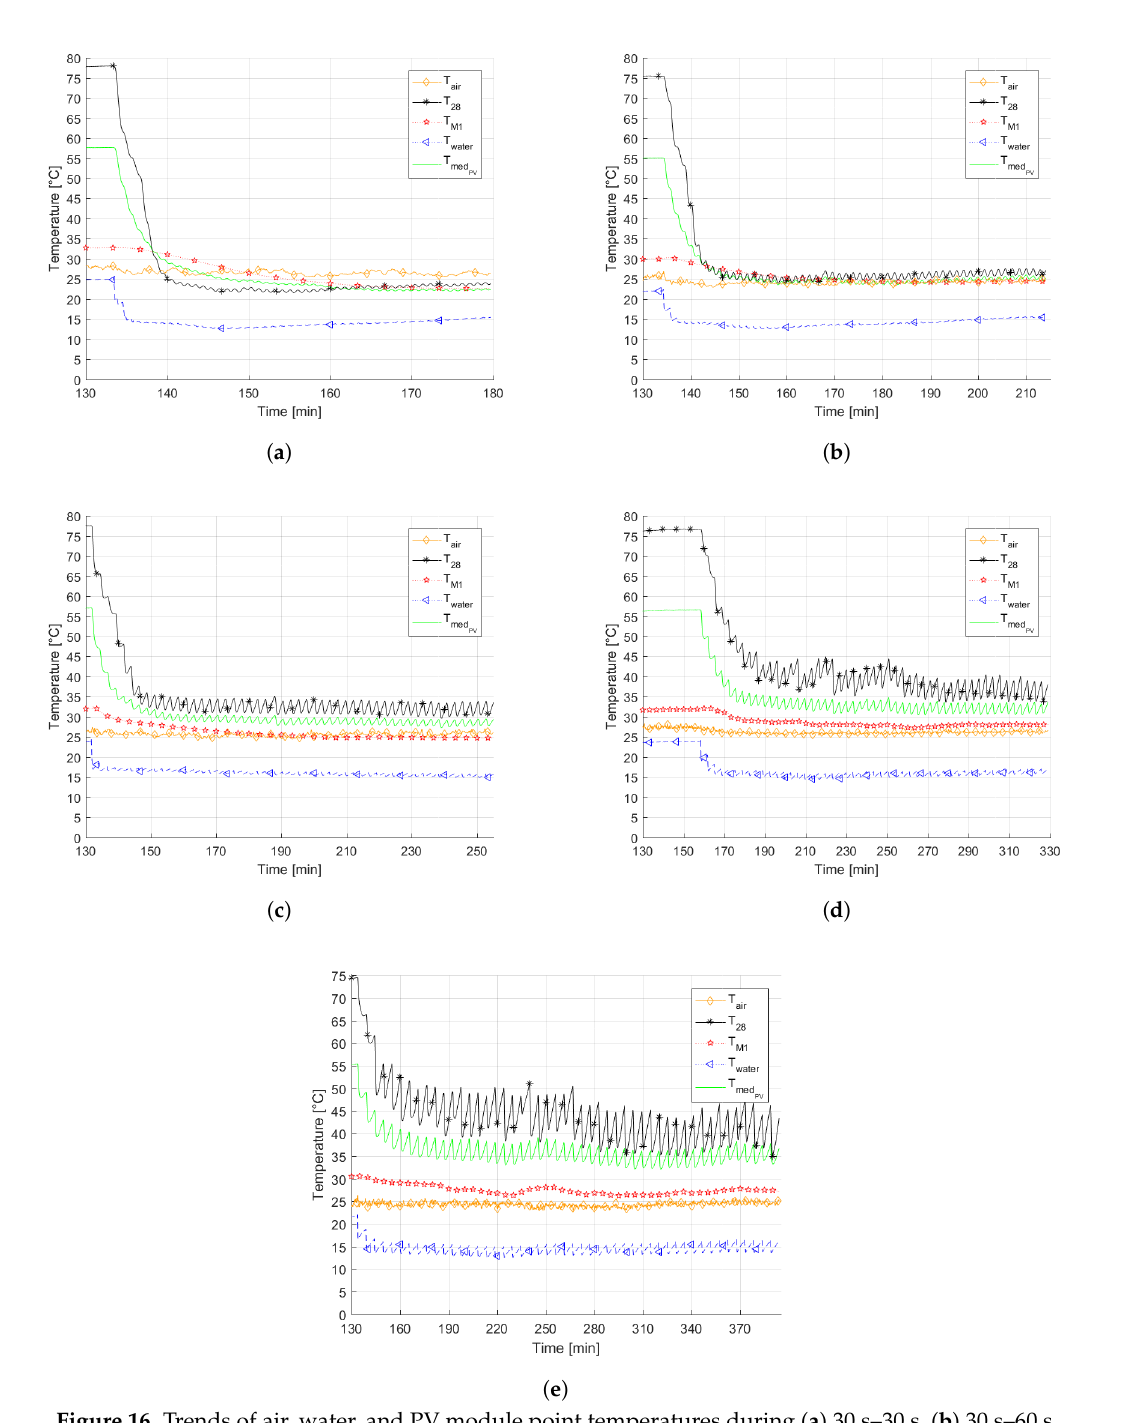
Figure 16. Trends of air, water, and PV module point temperatures during ( a ) 30 s–30 s, ( b ) 30 s–60 s, ( c ) 30 s–120 s, ( d ) 30 s–180 s, and ( e ) 30 s–300 s